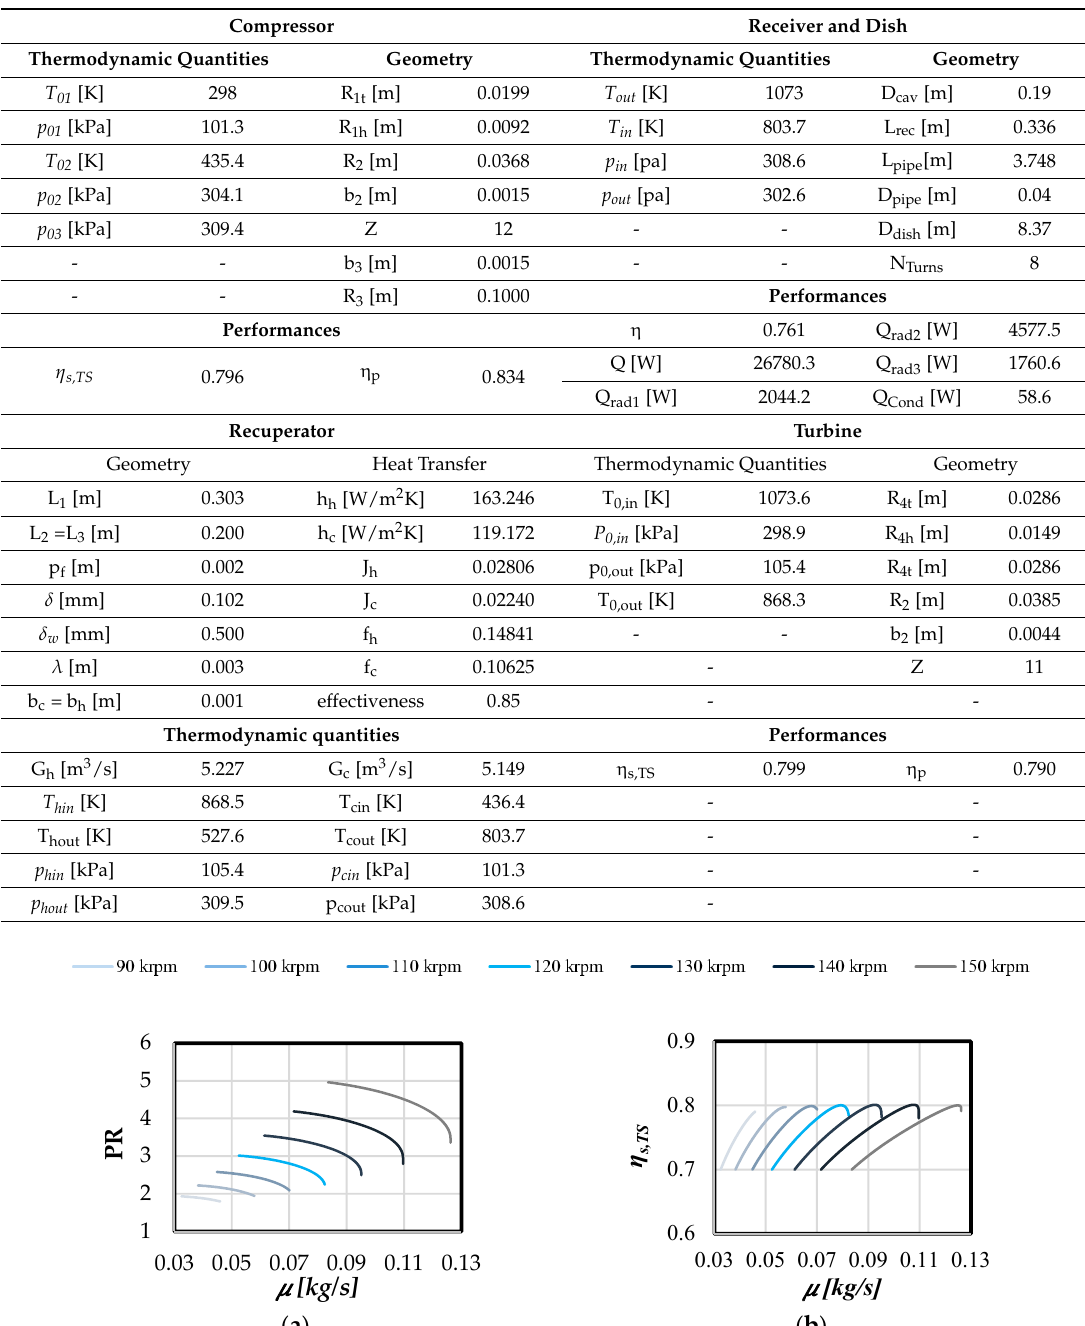
Table A1. Detailed results of the component designs for the compressor, receiver, dish, recuperator and the turbine.